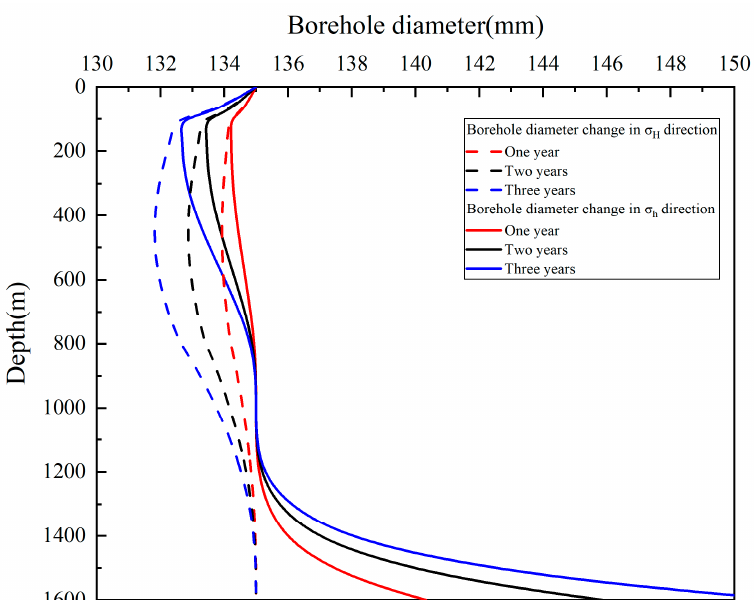
Figure 6. Calculated borehole diameter changes with time for a 1600 m hole at Dome A.